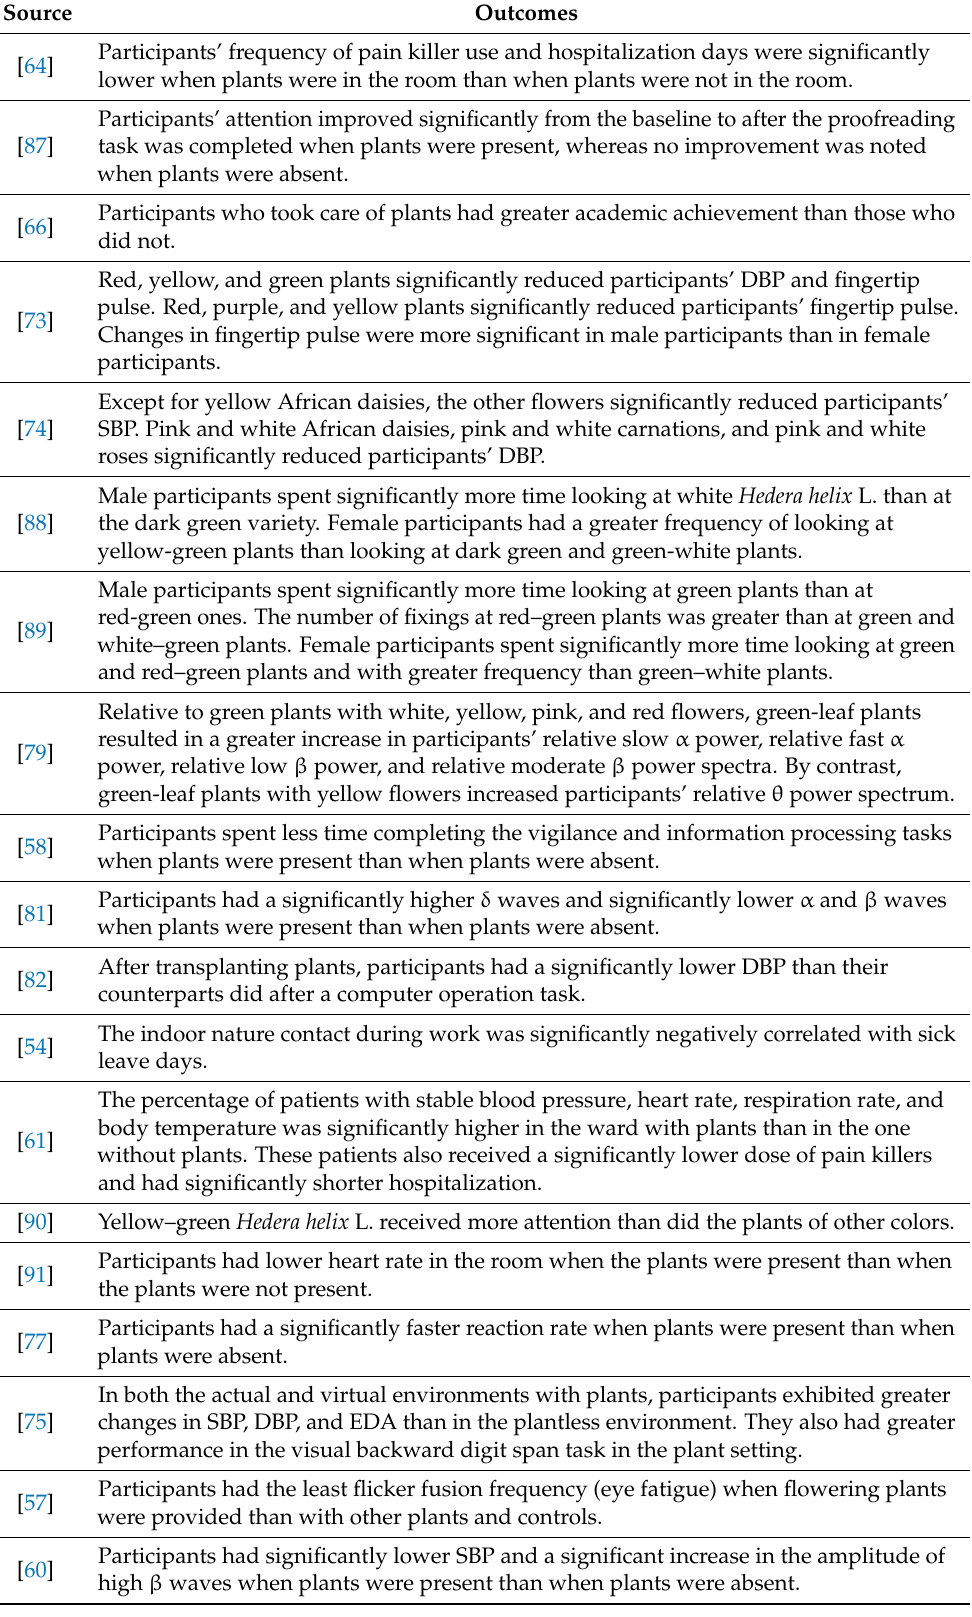
Table 7. Cont. Source